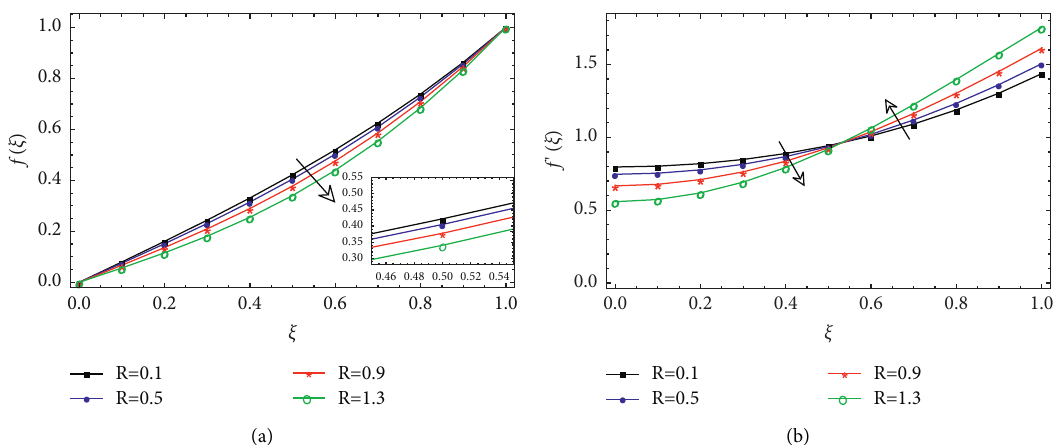
Figure 6: Effect of R on the velocity profile keeping M